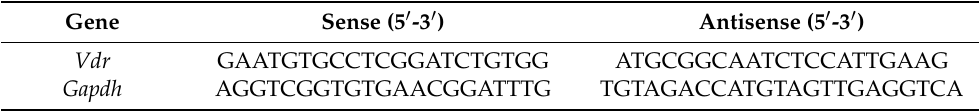
Table 1. The sequences of the primers for RT-qPCR assays.